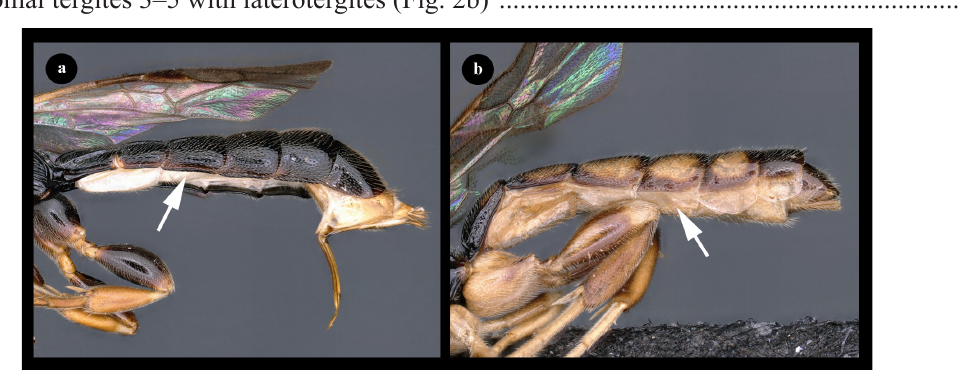
Fig. 2. a . Trieces irwini Ranjith & Priyadarsanan, 2022, metasoma, lateral view. b . Exochus sp., metasoma, lateral view. Arrow in Fig. 2a points to the lack of laterotergite on metasomal tergite 3–5 (compared to the presence of laterotergite on metasomal tergites 3–5 in Fig.